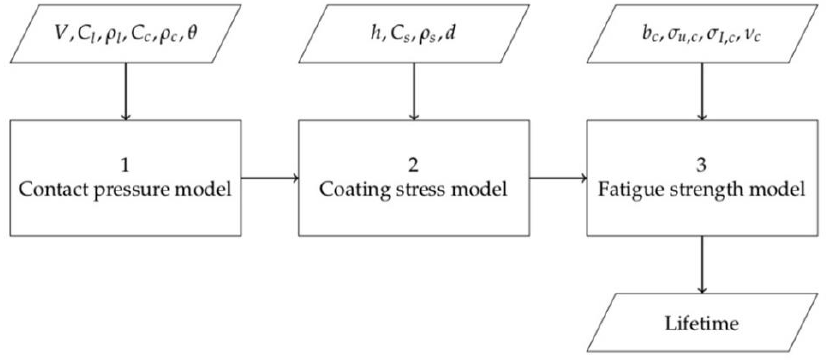
Figure 20. The Springer model overview [134].